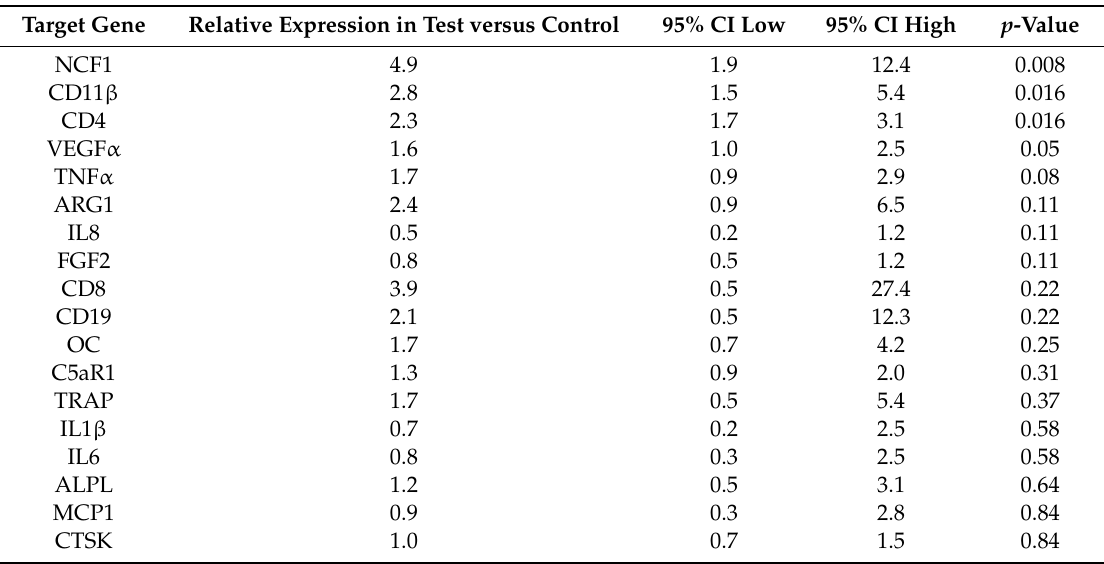
Table 2. Relative expression of the selected gene targets in the soft tissues around implants with silk ligature versus the soft tissues around controls (no ligature